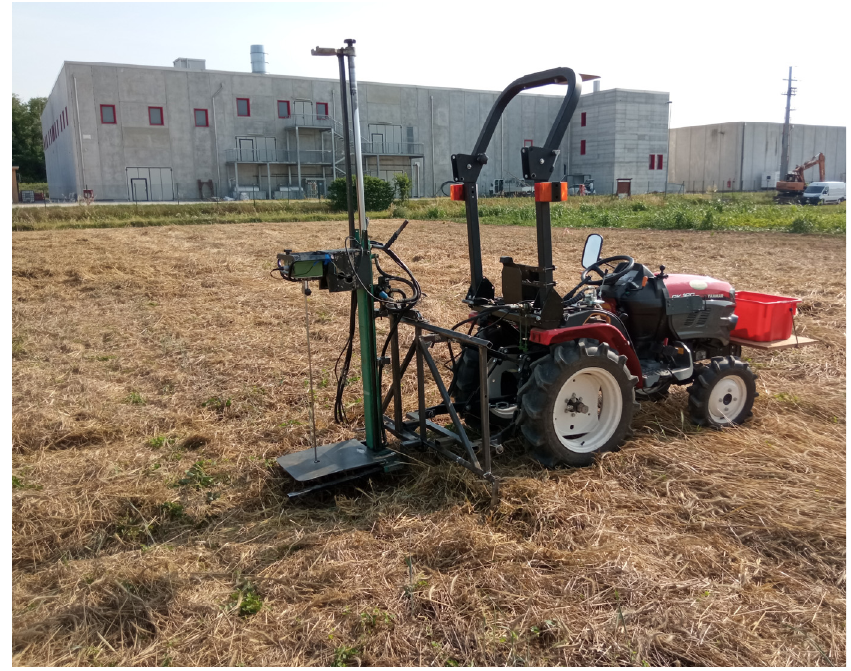
Figure 4. A penetrometer was installed on an iron frame with hydraulic ram to insert the cone tip at constant speed in the soil.